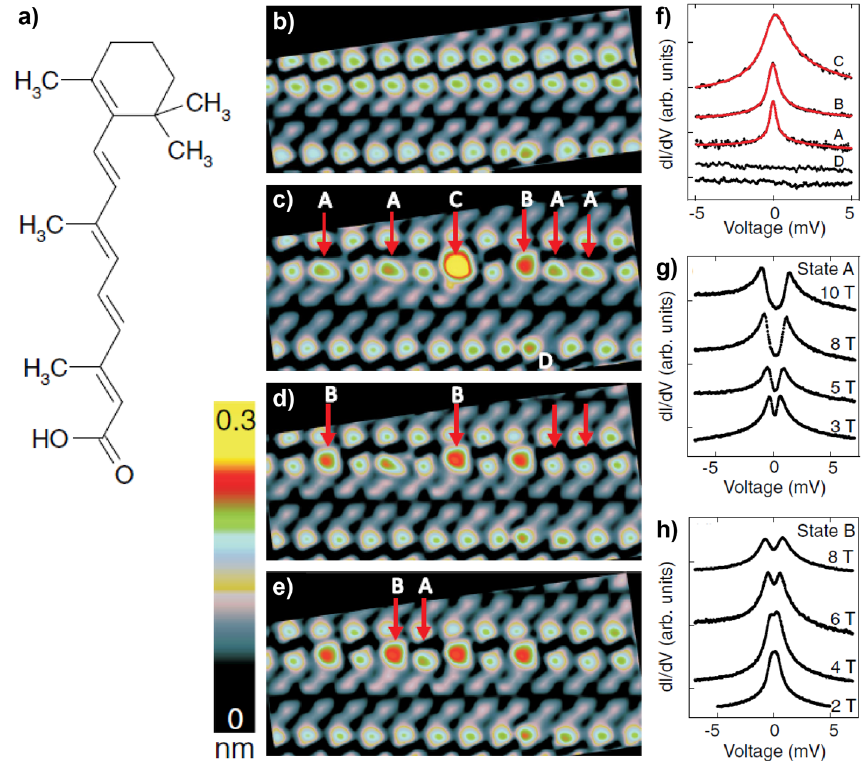
Figure 2. ( a ) Chemical structure of retinoic acid (ReA). ( b ) STM image of the striped pattern formed by ReA molecules in their pristine form as deposited on Au(111). ( c – e ) STM images of the same area after manipulating the marked molecules at a sample voltage V = − 2.5 V. ( f ) d I / d V spectra recorded at pristine (bottom curve) and four manipulated states of ReA. Magnetic field evolutions of states ( g ) A and ( h ) B. Adapted from [54], with permission from American Physical Society, 2016.